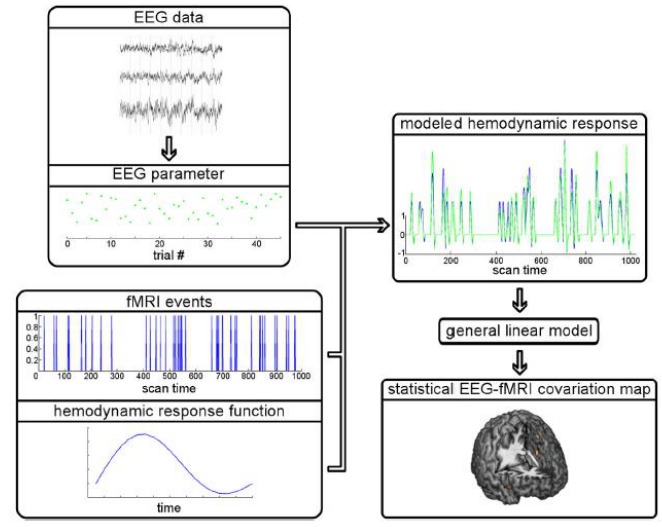
Figure 4. Schematic of EEG-informed fMRI. For an event of interest (e.g., the occurrence of a re-